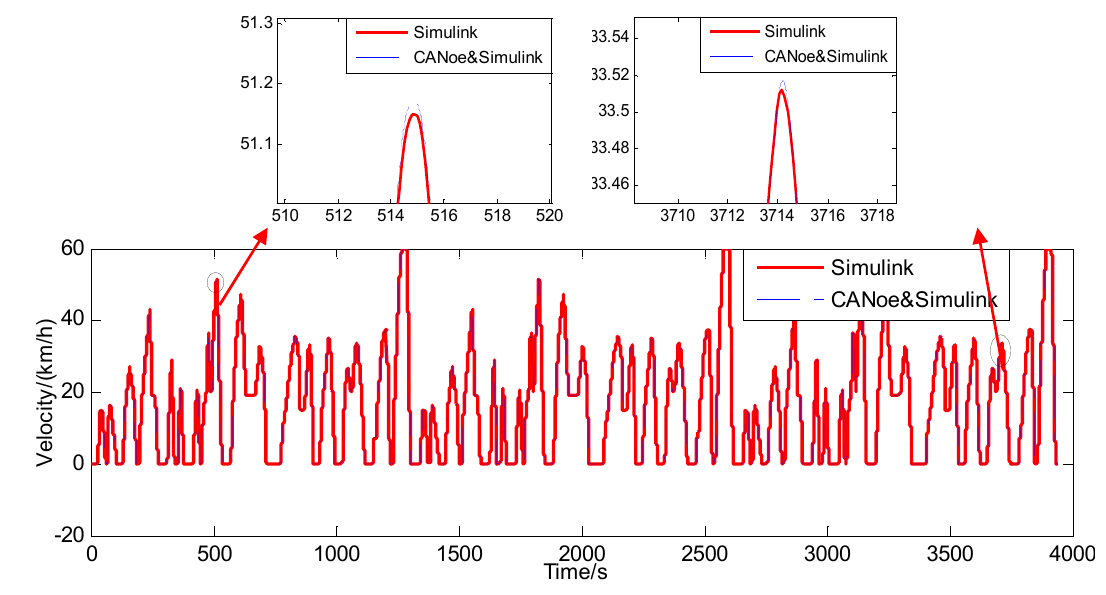
Figure 21. Velocity comparison from two kinds of simulations.